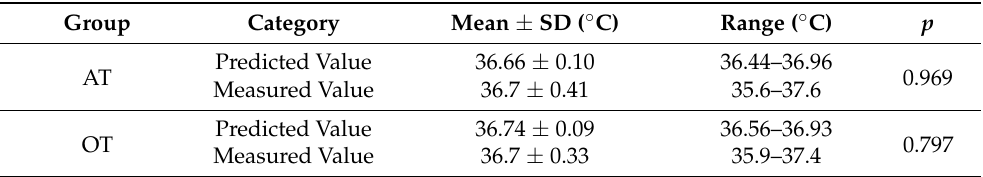
Table 3. Comparative analysis of the predicted value of the regression analysis curve and the measured value of the